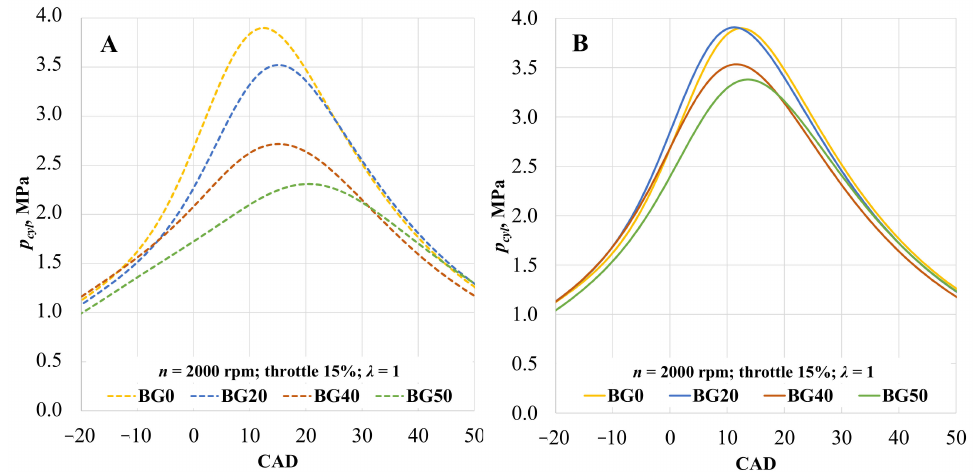
Figure 8. Change of the in-cylinder pressure depending on the volumetric fraction of CO 2 . ( A ) Constant ST, ( B ) Optimal